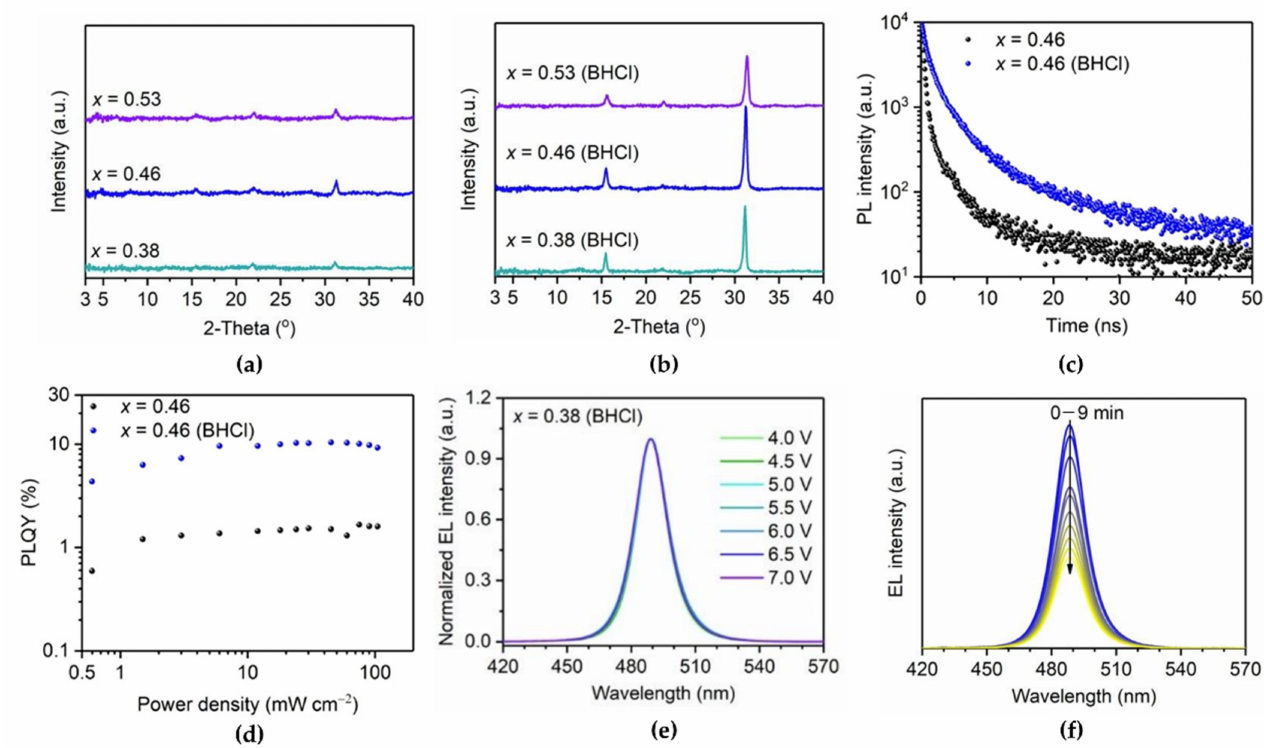
Figure 4. XRD patterns of ( a ) CsPb(Br 1 − x Cl x ) 3 and ( b ) benzamidine hydrochloride (BHCl)-treated CsPb(Br 1 − x Cl x ) 3 films with varying x . ( c ) PL decay curves and ( d ) power-dependent PLQYs of control and BHCl-treated CsPb(Br 0.54 Cl 0.46 ) 3 films. ( e ) Normalized electroluminescence (EL) spectra of PeLEDs with x = 0.38 (BHCl) film. ( f ) EL spectra of PeLED with x = 0.38 (BHCl) under a constant current density of 5 mA/cm 2 . Reprinted with permission from [44], Copyright 2021 American Chemical